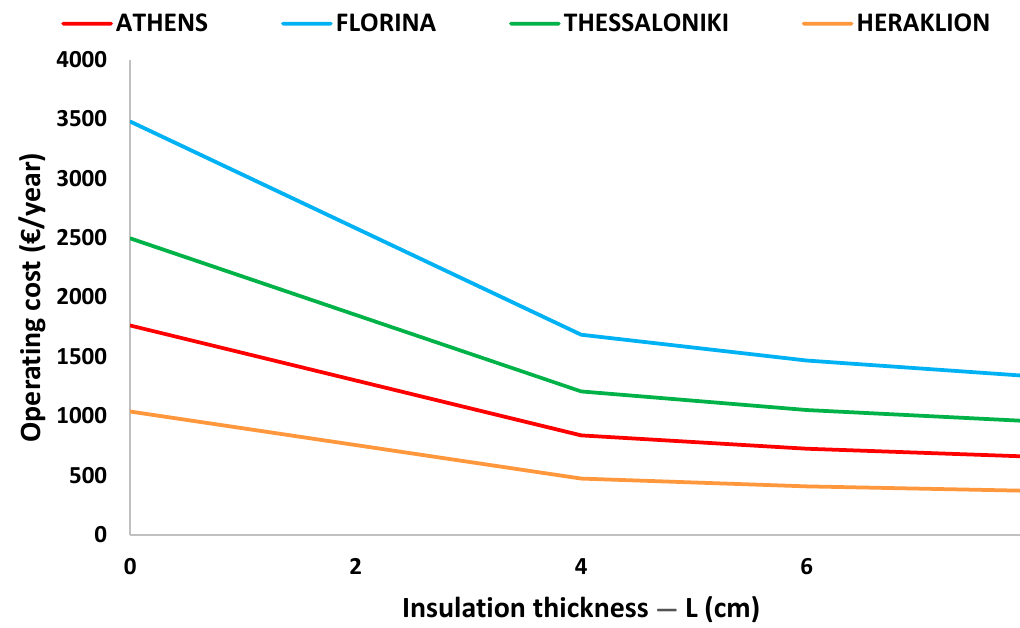
Figure 7. Total yearly operating cost for the examined cases.